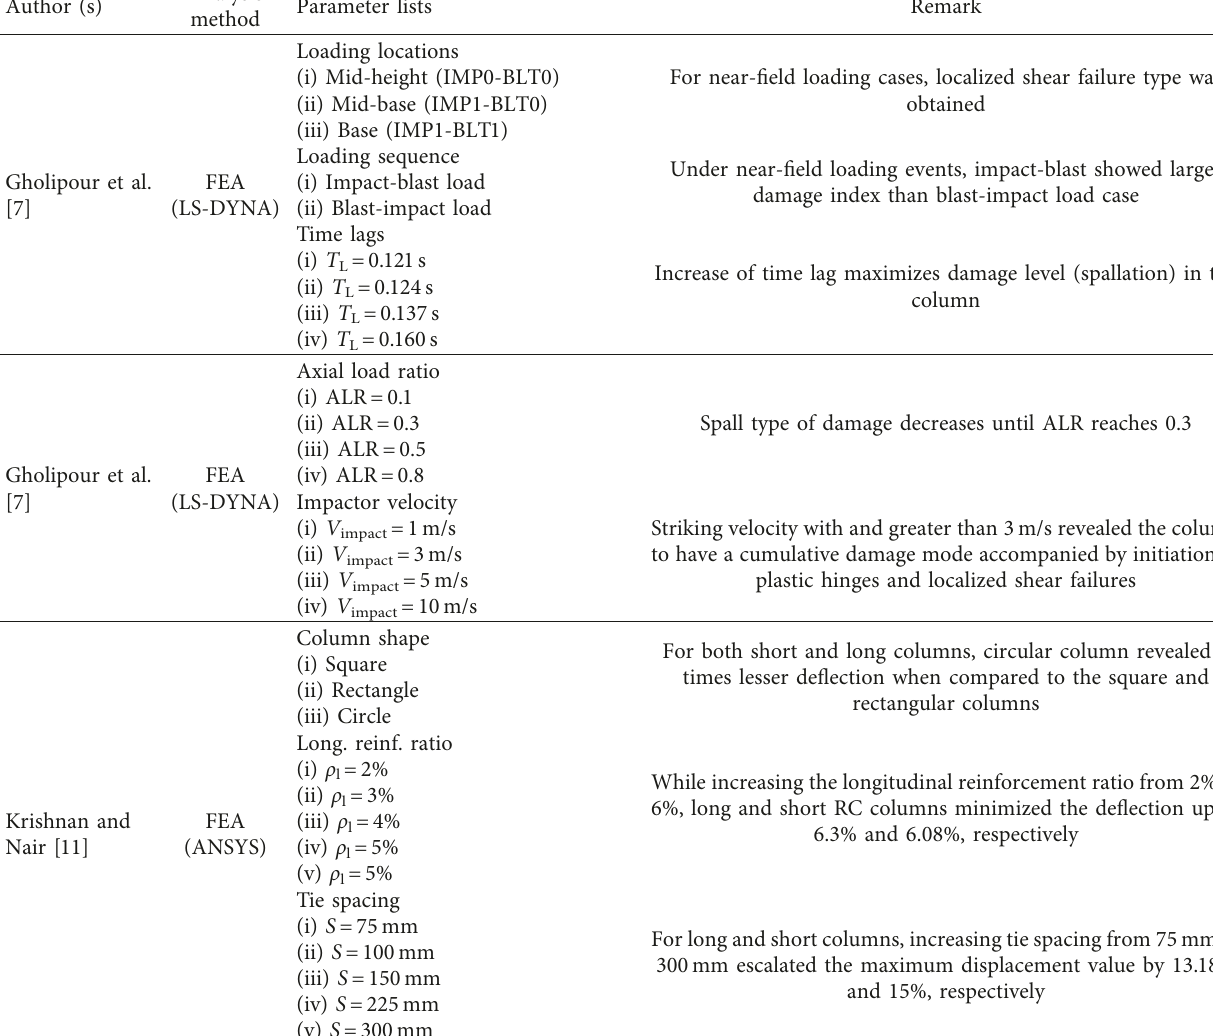
Table 5: Summary of FEA numerical simulation failure modes for RC column under combined loading cases [7]. Failure modes of RC column loaded at mid-height with middle-rate, near, and far field loading accompanied by different loading sequences Combined near-field loading